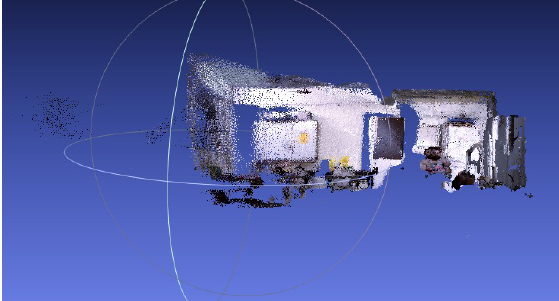
Figure 5. 3D Map obtained through Kinect sensor.